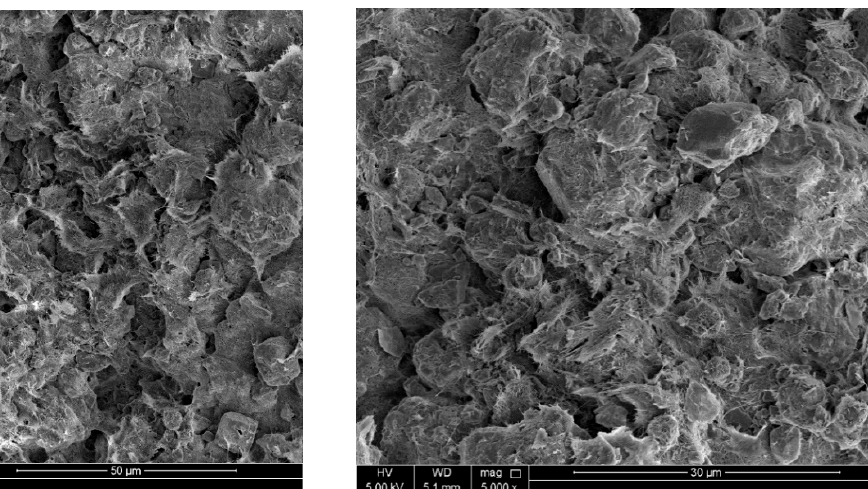
Figure 5. SEM images of TBM muck Sample #2 at different scales.